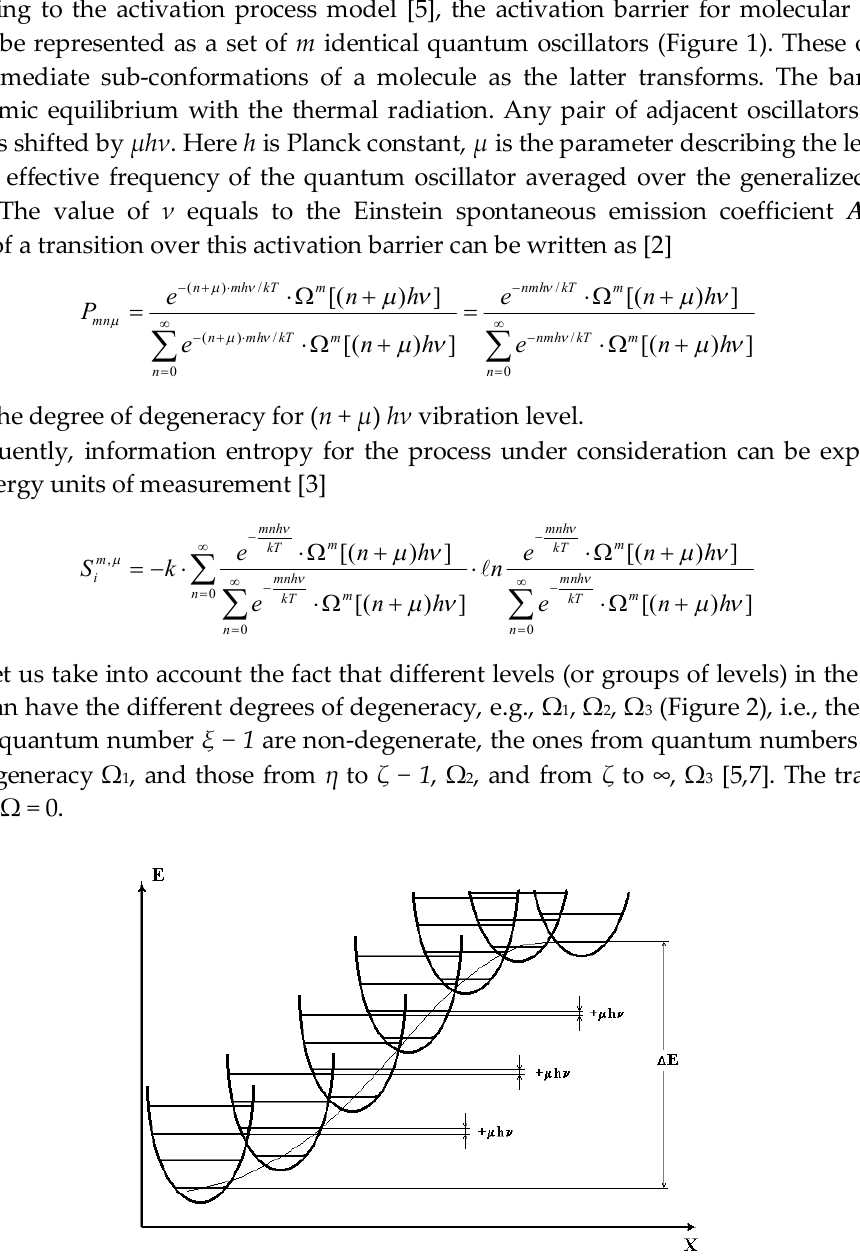
Figure 1. Arrangement of the quantum oscillators averaged over the generalized coordinate of chemical reaction on the potential